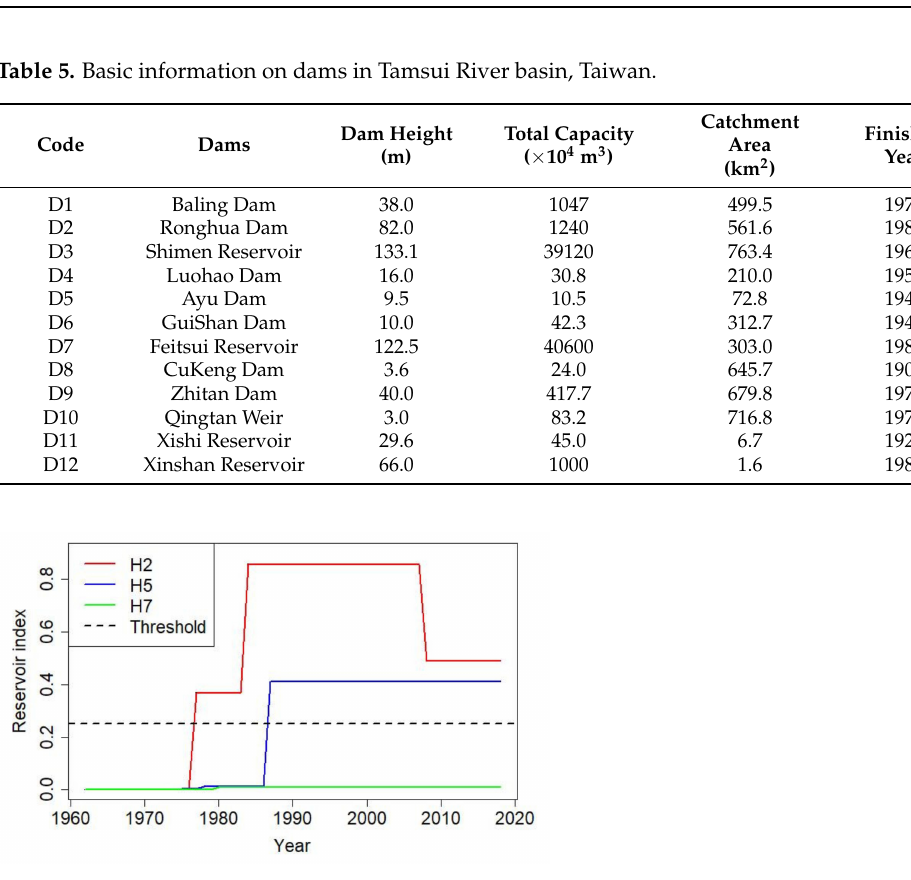
Figure 3. Evolution of reservoir index with time at H2, H5, and H7 in Tamsui River basin,